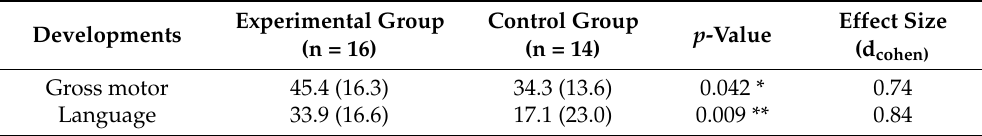
Table 3. Mean (SD) of intra-individual variability (changes) of developments. Developments